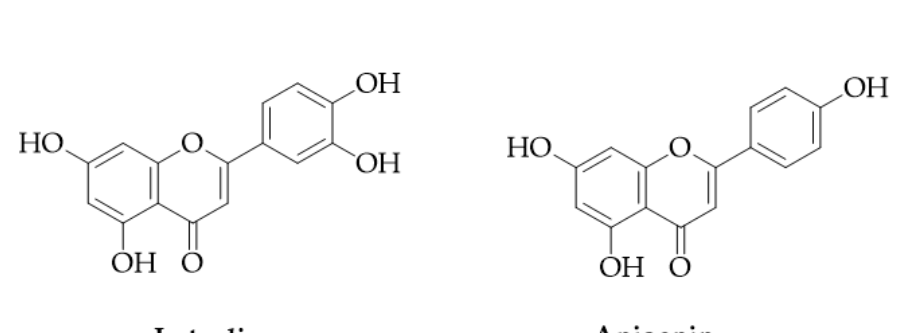
Figure 2. Quantification of luteolin and apigenin in EVOO extracts (OE). 3.7. Evaluation of Protective Effects of OE_05 , OE_10 , and OE_15 on CaCo-2 Cells 3.7.1. MTT Assay Upon arrival, EVOO extracts were suspended in 100 μ L of DMSO and stored at 4 °C, avoiding direct light. The MTT assays for OE_05 , OE_10 , and OE_15 were performed on CaCo-2 cells to evaluate the non-toxic treatment dose. Cells were treated for 24 h with different concentration of EVOO extracts (2, 5, 10, 20, and 50 μ g/mL) and DMSO at different doses (vehicle 1 and vehicle 2), suspended in completed DMEM high-glucose media.